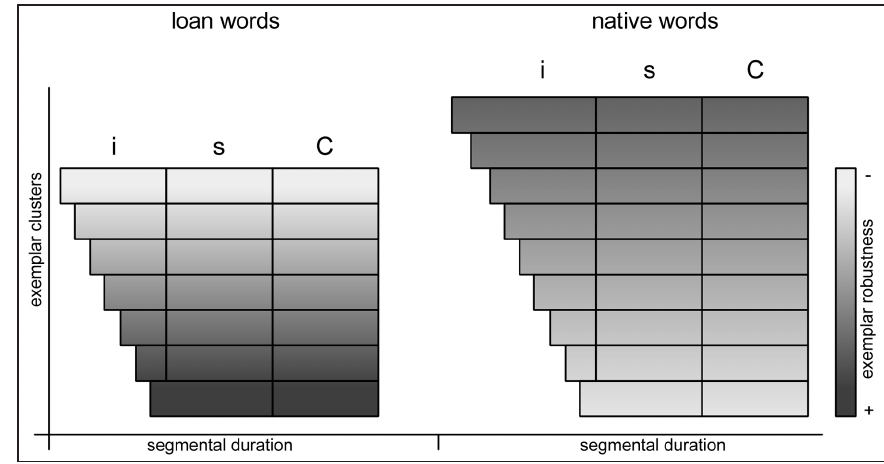
Figure 3: Exemplar representations for